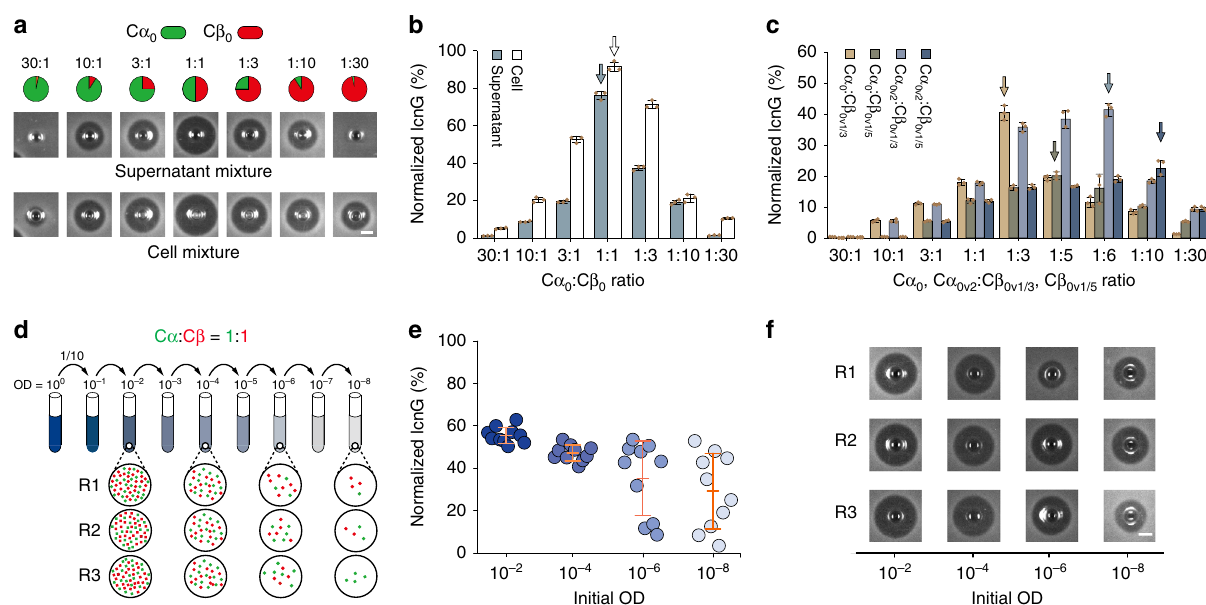
Fig. 2 Characterization of cooperation variations. a Representative inhibition zones formed by different ratios of supernatant mixes from the C α 0 and C β 0 monocultures (top row) and the supernatants of the C α 0 -C β 0 co-cultures growing from different initial ratios (bottom row). b Relative lcnG levels in the monoculture supernatant mixes (white bars) and the co-culture supernatants (blue bars) ( n = 3). Here, the lcnG concentration is normalized by the lcnG productivity of the single lcnG-producing strain C αβ . c Normalized lcnG levels in the supernatant mixes of monoculture C α 0 and C β 0 variants ( n = 3). C α 0v2 is a C α variant that has a doubled peptide α productivity compared to C α 0 . C β 0v1/3 and C β 0v1/5 are two C β 0 variants, whose peptide β productivities are 1/3 and 1/5 of that of C β 0 . d Schematic illustration of population fl uctuations during serial dilution. Variations of the cooperator ratio increase with reducing initial cell density, resulting in different abundances across replicates (R1, R2, and R3). e Normalized lcnG concentration of the C α -C β co-culture from different initial ODs but a fi xed 1:1 ratio. Each circle represents the lcnG level from a single experiment. For each OD, there are a total of 10 replicates ( n = 10). f Representative inhibition zones formed by the consortium growing from different initial ODs. In panel b , c , and e , bars and error bars correspond to means and s.d. In panels a and f , scale bars, 3 mm. Source Data available in the source data fi